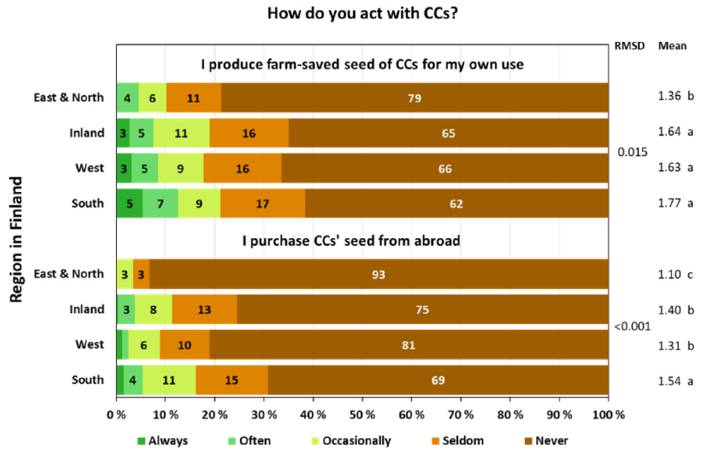
Figure 9. The distribution of farmers’ answers (N = 1130) depending on the region in Finland (RMSD, row mean scores difference; CCs, cover crops).